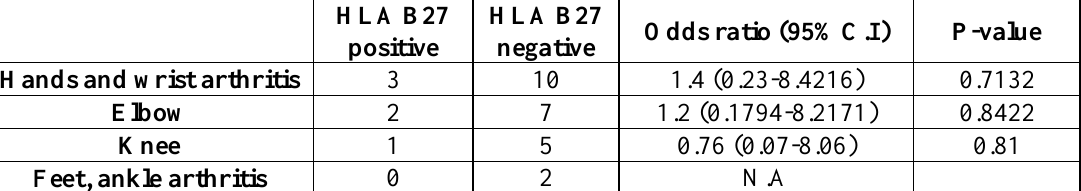
Table(4): Association between HLA B27 and joint manifestation.